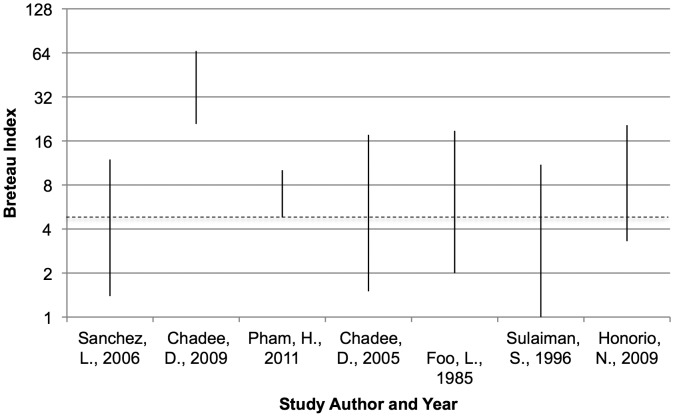
Range of Breteau indexes reported during dengue transmission.Dotted line indicates a BI value of 5, which has been considered a transmission threshold for dengue [21], [45], [52]. Note: Includes all data where available, whether statistically significant or insignificant.